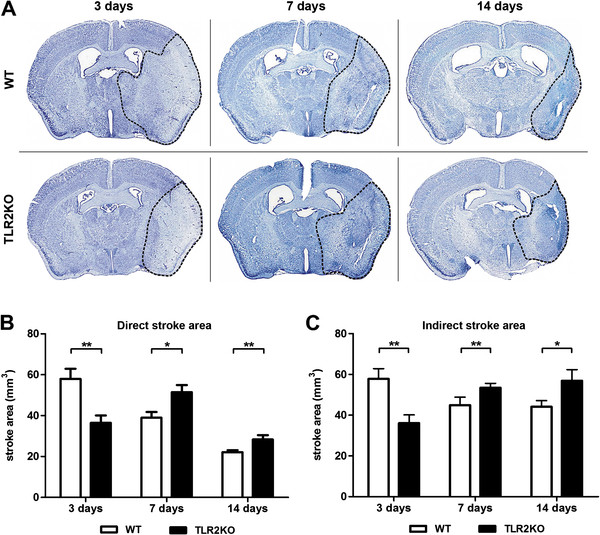
Toll-like receptor 2 deficiency delays evolution of ischemic brain lesion. (A) Representative low-magnification photomicrographs of cresyl violet stained brain sections of wild type (WT) and Toll-like receptor (TLR) 2−/− mice 3, 7 and 14 days after transient middle cerebral artery occlusion (MCAO). The ischemic area is emphasized by a black dashed line. (B) Significantly reduced direct stroke area in TLR2−/− mice 3 days after transient MCAO compared with WT mice. This was followed by marked lesion exacerbation in TLR2−/− mice 7 days after injury, while lesions in WT mice showed a reduction in size. The evolution of direct stroke area stagnated 14 days after injury, indicating significantly larger final lesion size in TLR2−/− mice compared with the WT group. (C) A smaller indirect stroke area in TLR2−/− mice compared with WT mice 3 days after transient MCAO. In contrast, 7 days after injury, indirect stroke area in the TLR2−/− group was larger compared with WT mice, and the same relationship was observed 14 days after ischemic injury. Values are expressed as mean ± SEM (n = 10, *P <0.05, **P <0.001).